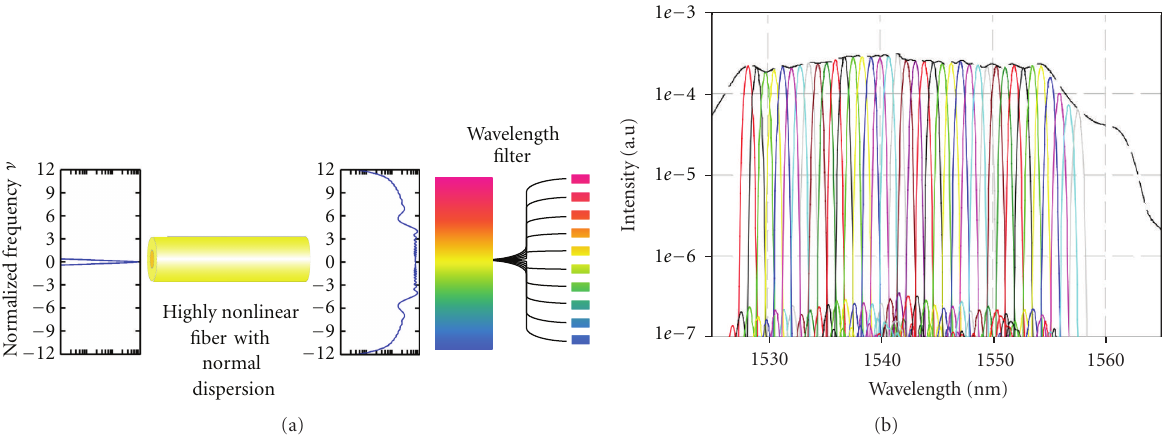
Figure 4: (a) Principle of operation of a multiwavelength picosecond source. (b) Experimental spectrum of a parabolic-shaped pulse after propagation in a ND-HNL fibre (black dashed line) and superposition of the measured spectra of 38 sliced channels. Results adapted from